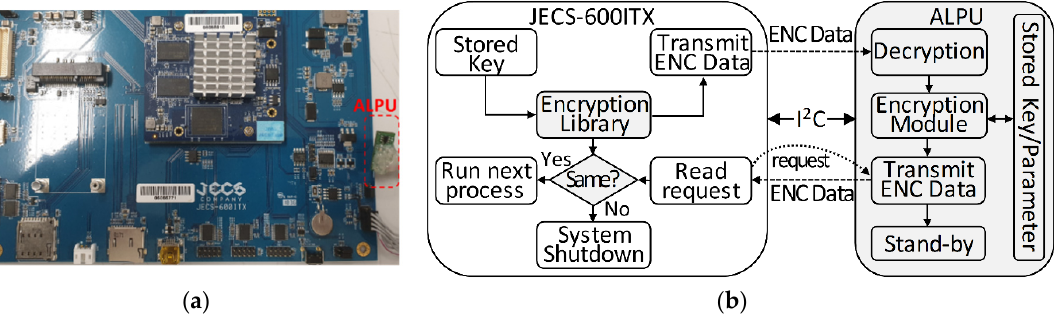
Figure 3. JECS-600ITX with Algorithm License Permittuition Unit (ALPU): ( a ) actual hardware; ( b ) authentication process.